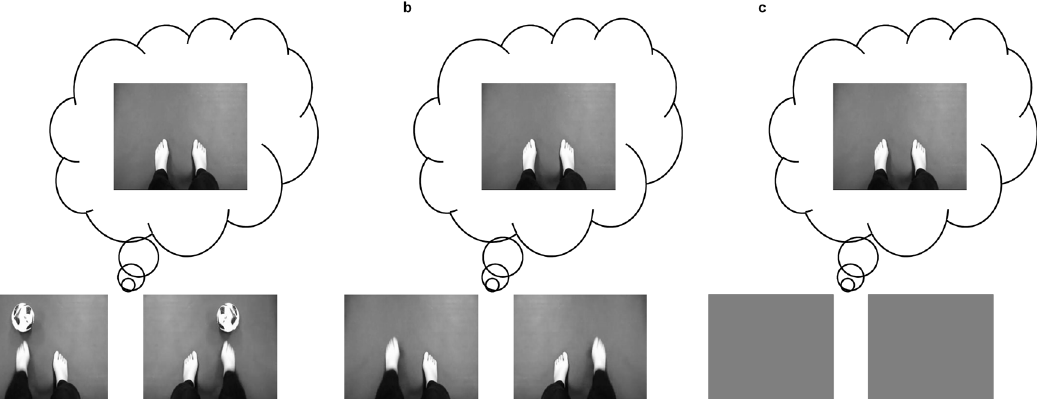
Fig 2. Three different tasks: (a) imagining a leg flexion-extension under the object stimulus (OI); (b) imagining a leg flexion-extension without goal (NI); (c) imagining a leg flexion-extension without the stimulus